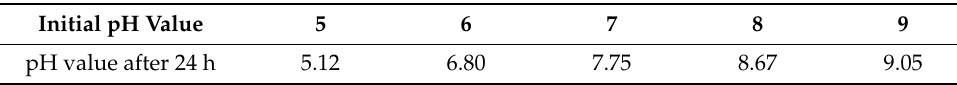
Figure 6. Influence of initial pH value on nitrogen compounds removal on Vibrio sp. LY1024. Table 2. Variation of solution pH value before and after culture.